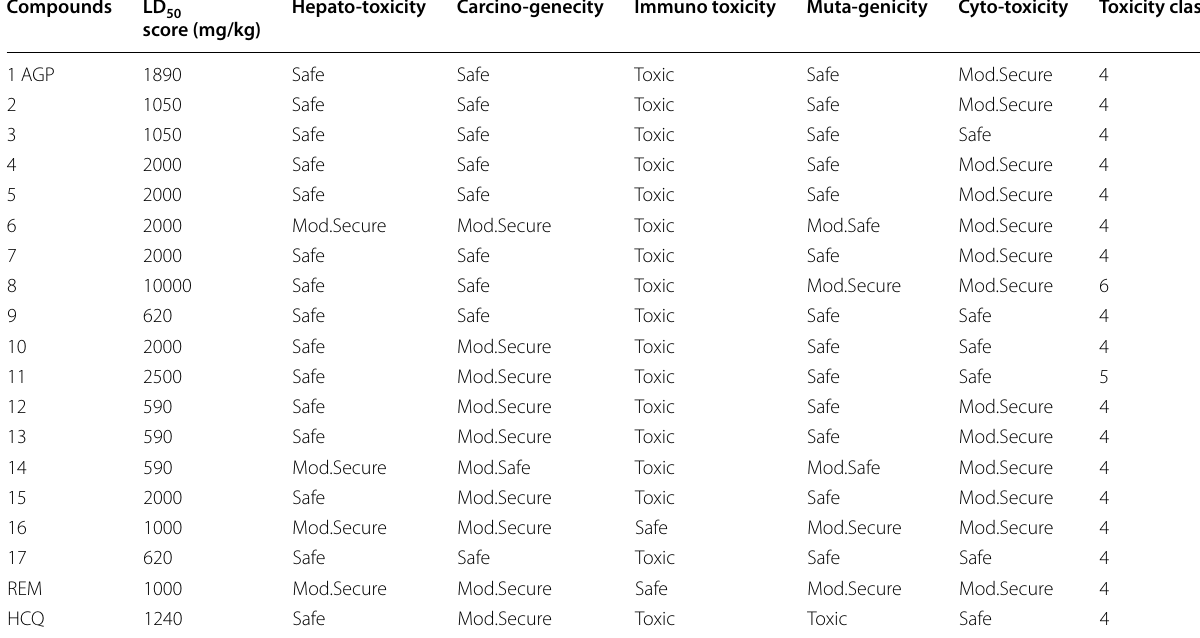
Table 2 Toxicity profile of AGP